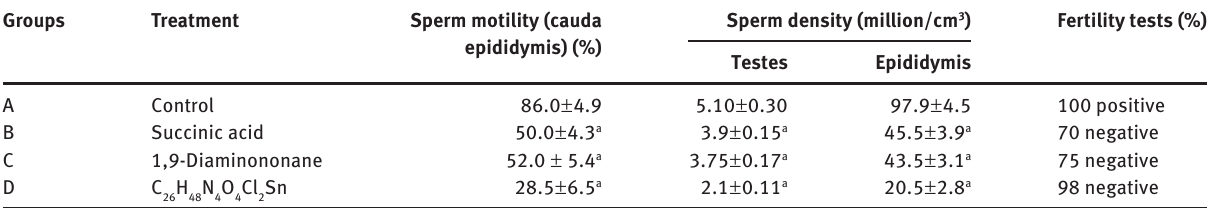
Table 7 Altered sperm dynamics of the starting materials and their tin(II) complex on treated rats. Groups